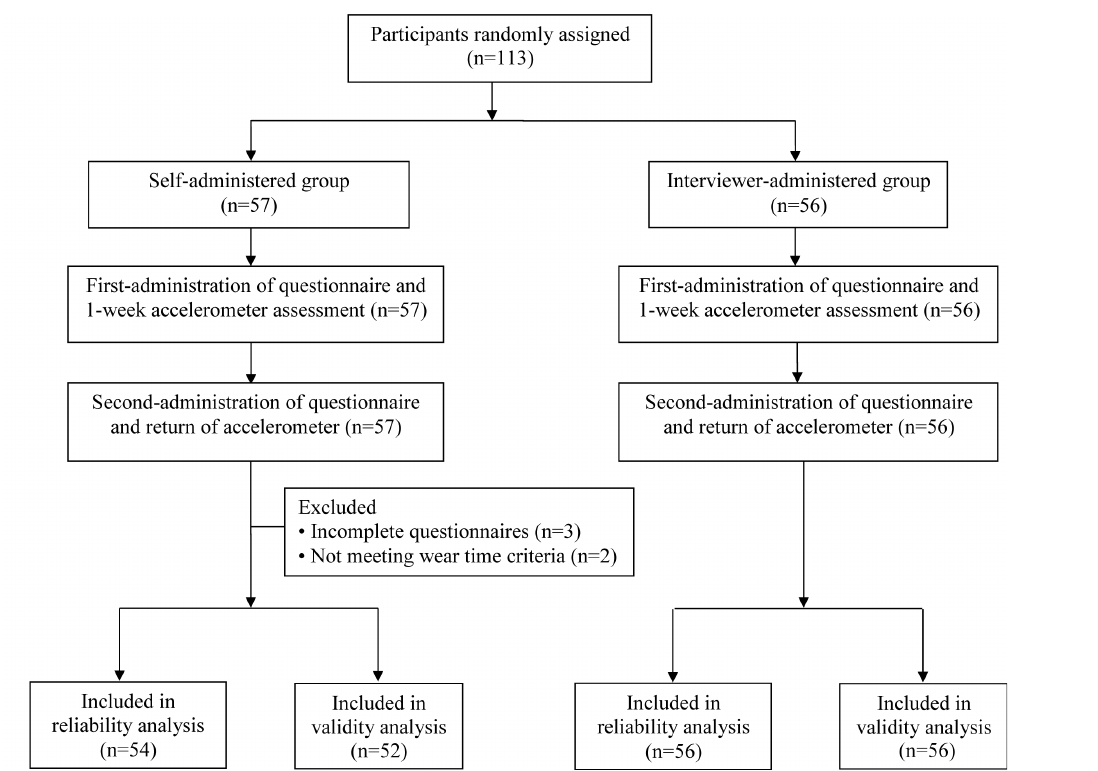
Fig 1. Flowchart of participants ’